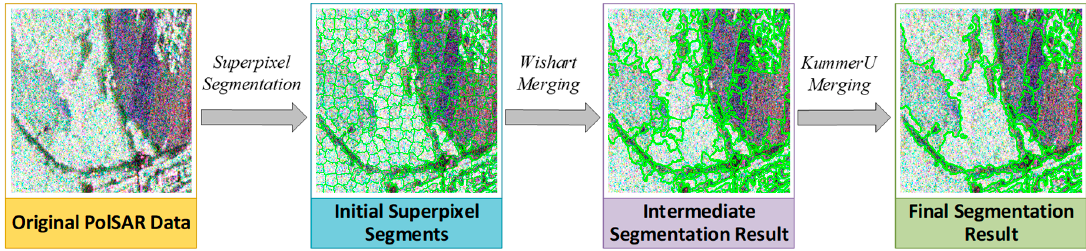
Figure 3. Flowchart of the proposed segmentation method.